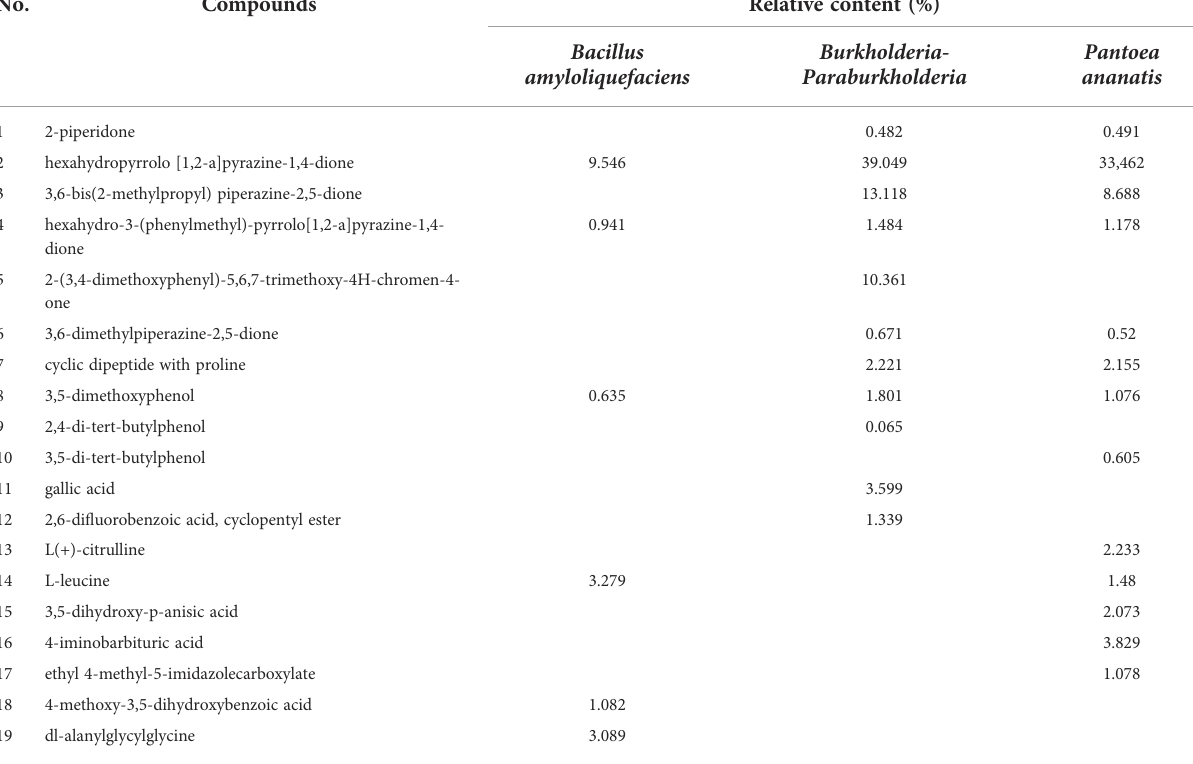
TABLE 2 The main secondary metabolites in the fermentation broths of Bacillus amyloliquefaciens, Burkholderia-Paraburkholderia , and Pantoea ananatis . No. Compounds Relative content